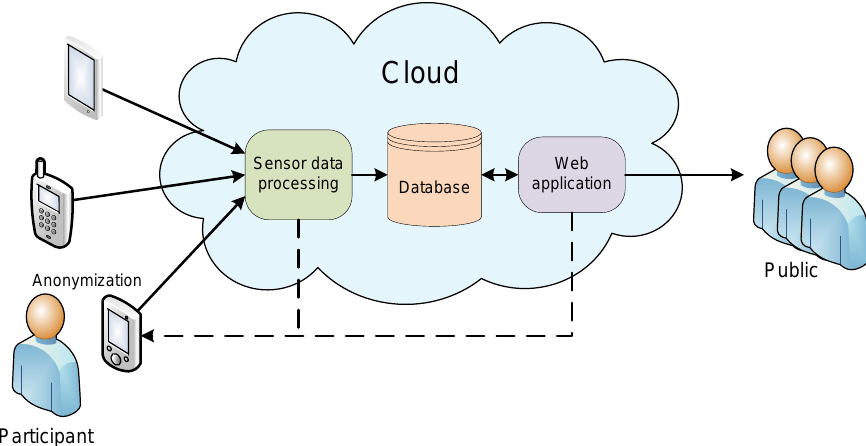
Figure 8. Cloud based participatory sensing system architecture. Smartphones send sensor data to the cloud for processing. Processed sensor data results are stored in the cloud database. Results can be retrieved directly from the processing unit or through a cloud web